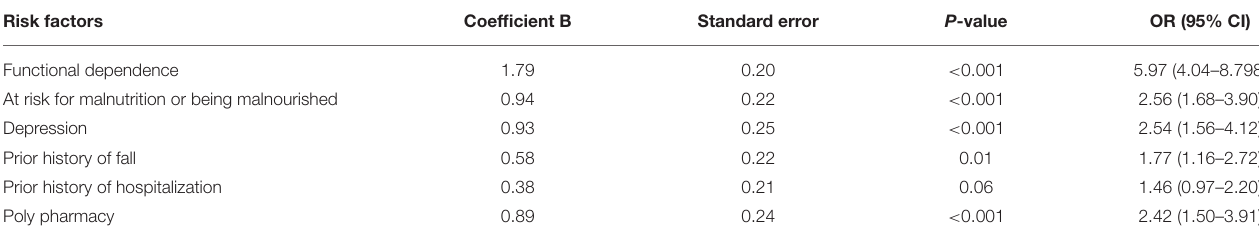
TABLE 3 | The risk factors associated with frailty in Indonesian